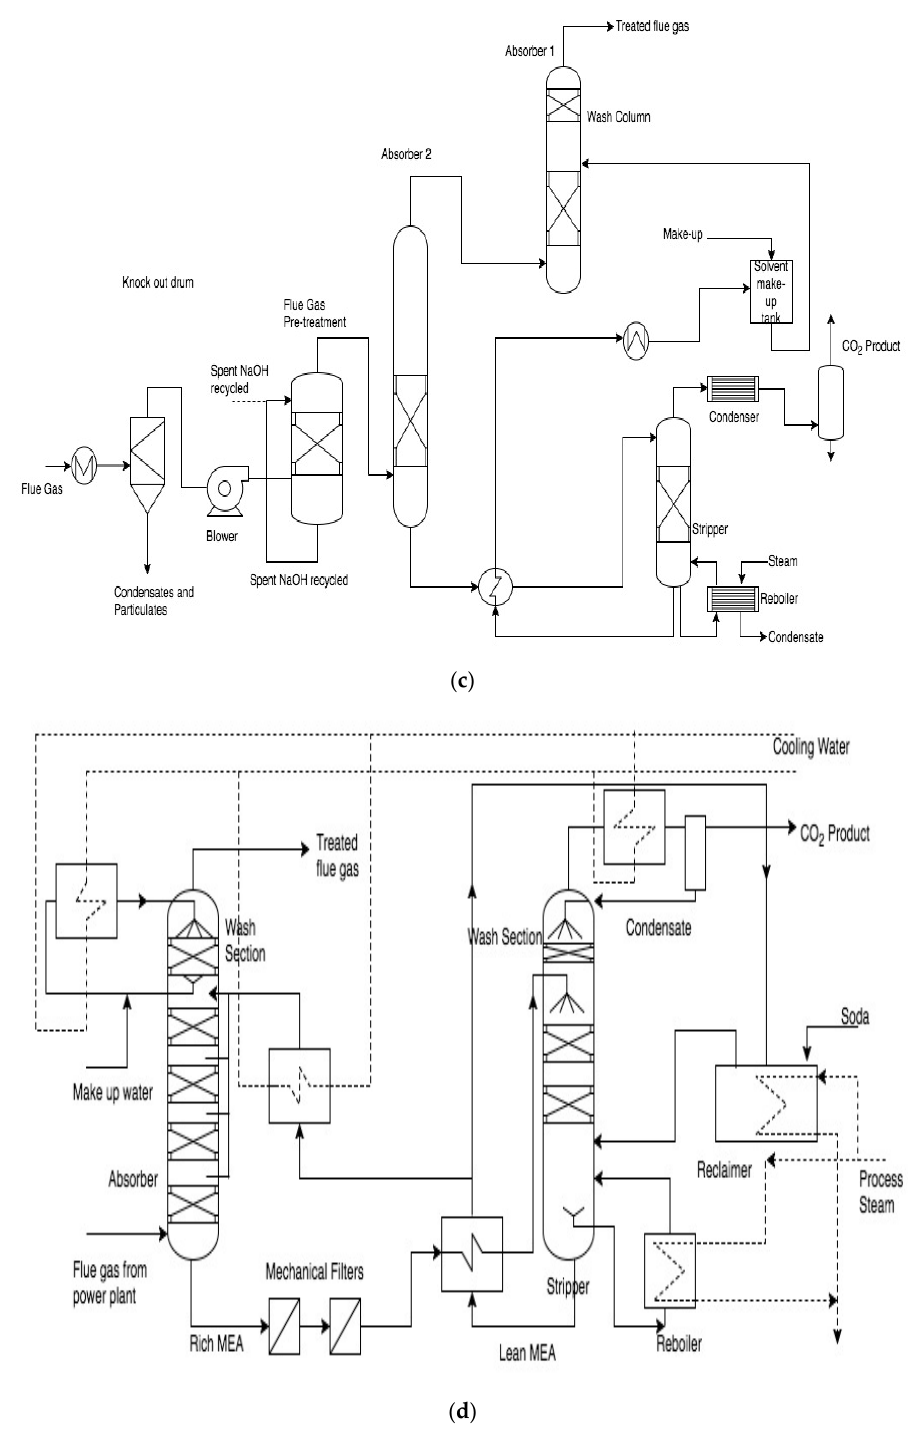
Figure 1. Fluid streams and main unit operations for pilot plants of ( a ) EnBW [27]; ( b ) TNO [28]; ( c ) CSIRO [29]; and ( d ) DONG [30]. ( c ) CSIRO [29]; and ( d ) DONG